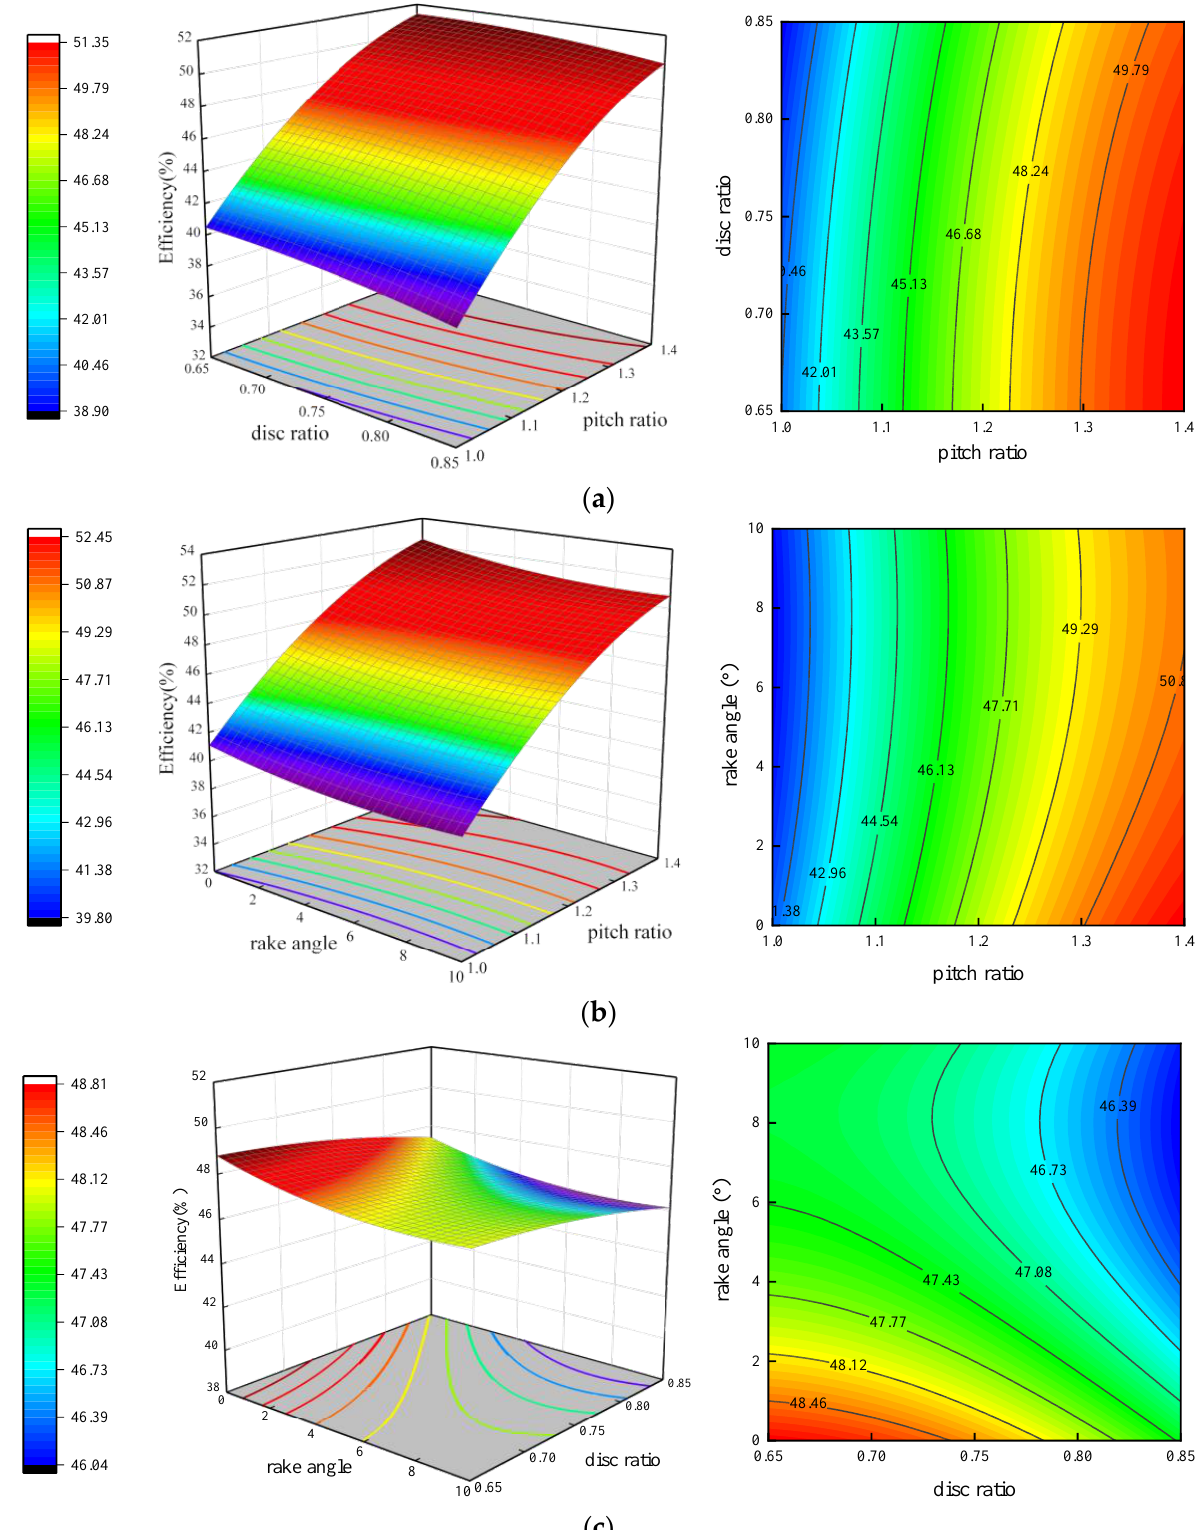
Figure 8. Interactions between different design variables. ( a ) Interactions between pitch ratio and disk surface ratio. ( b ) Interactions between pitch ratio and rake angle. ( c ) Interactions between disc ratio and rake angle.